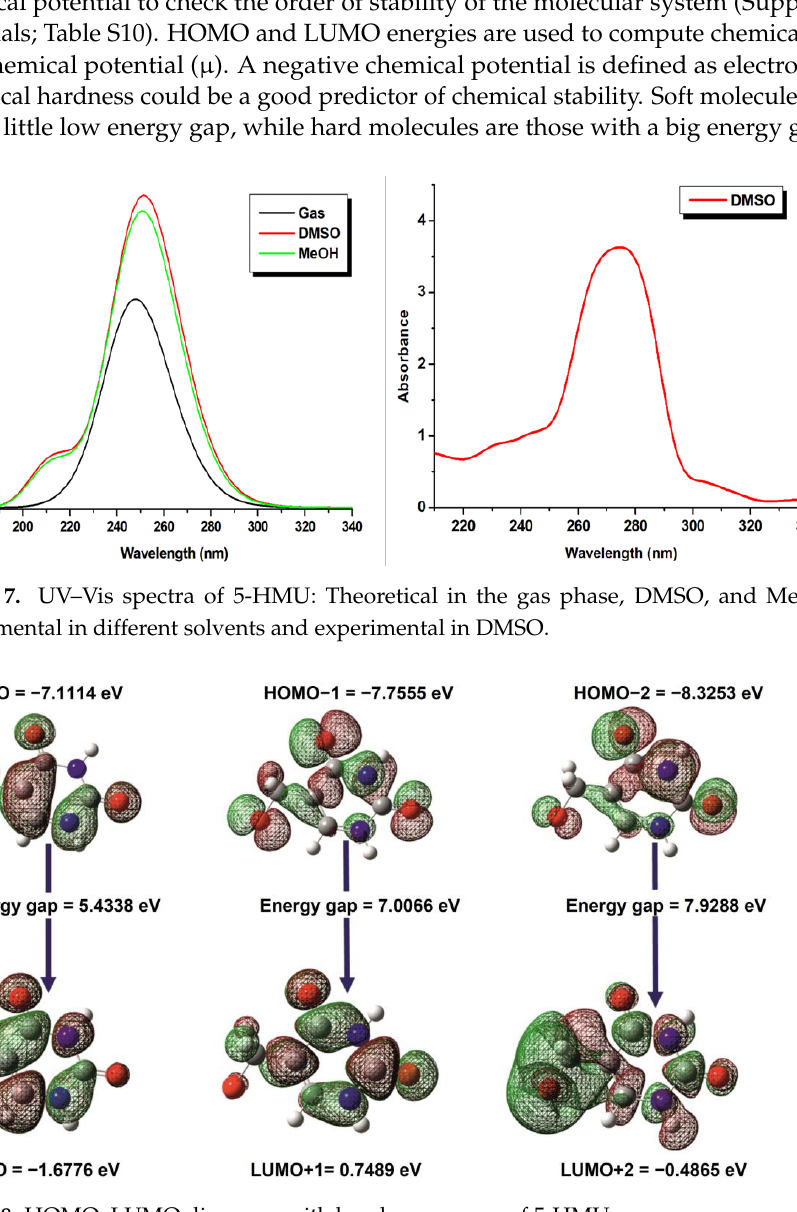
Figure 8. HOMO – LUMO diagrams with band gap energy of 5-HMU.